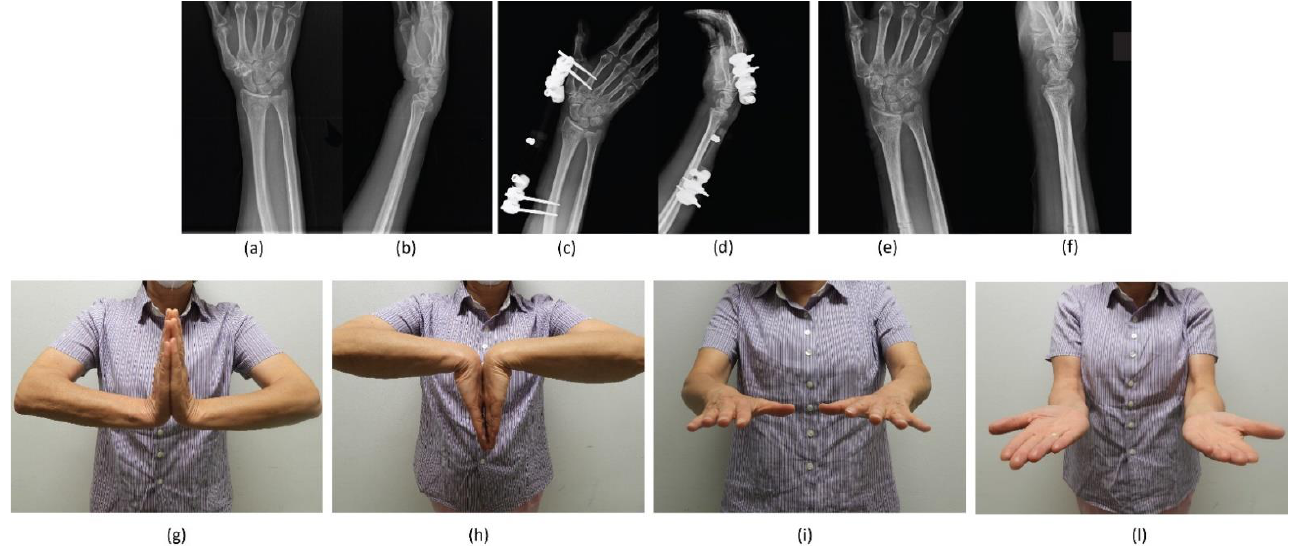
Figure 4. A 69-year-old female patient treated with BEF for an AO 23-B3 DRF. Antero-posterior (AP) and latero-lateral (LL) radiographic images at ( a , b ) pre-operative period; ( c , d ) immediate post- operative period; ( e , f ) at 2-month follow-up. Clinical-functional images showing: ( g ) extension, ( h ) flexion, ( i ) pronation, and ( l ) supination of the operated wrist at last follow-up.